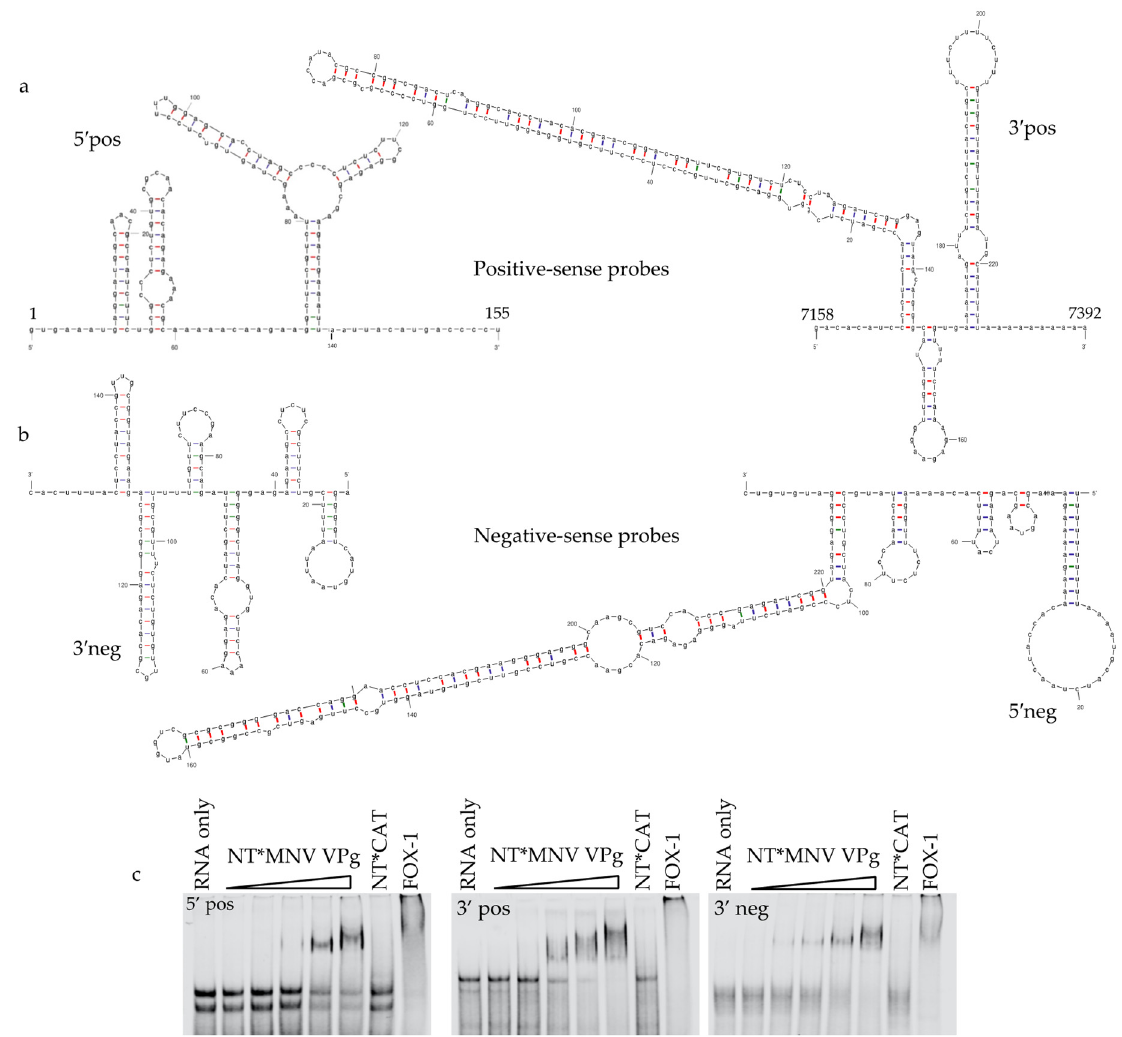
Figure 5. Viral RNA probes . ( a ) Schematic of the positive-sense viral RNA probes (5 ′ pos and 3 ′ pos). The genome positions of nucleotides for the positive-sense RNA probes are indicated. ( b ) Schematic of the negative-sense viral RNA probes 3 ′ neg and 5 ′ neg. The negative-sense RNA probes are the complements of the positive-sense RNA probes. RNA secondary structures ( a , b ) were predicted using mfold [44,45]. ( c ) NT*MNV VPg was incubated with labelled 5 ′ pos, 3 ′ pos or 3 ′ neg RNA probes and analysed by EMSA. The concentration of NT*MNV VPg was increased from 0.5 μ M to 8 μ M in 2-fold increments. NT*CAT (8 μ M) and FOX-1 (8 μ M) were included as negative and positive controls, respectively.